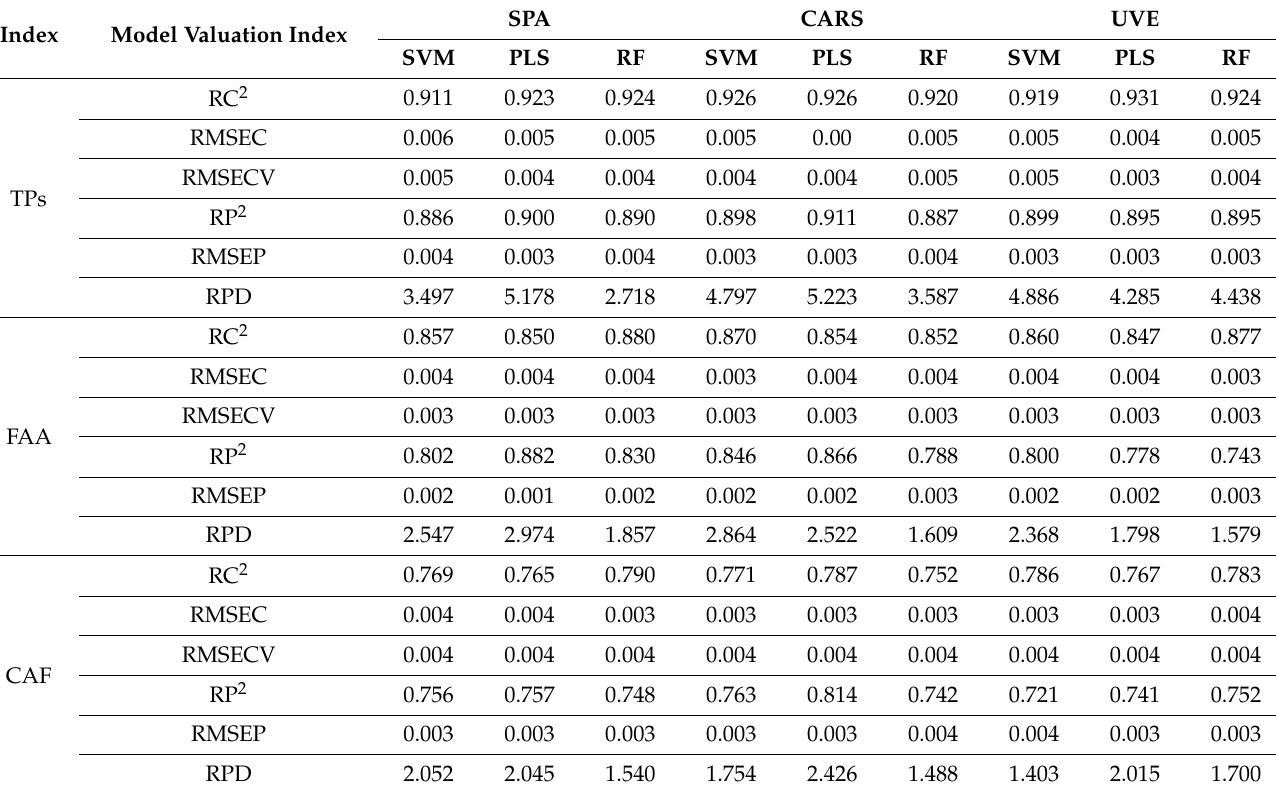
Table 4. Modeling